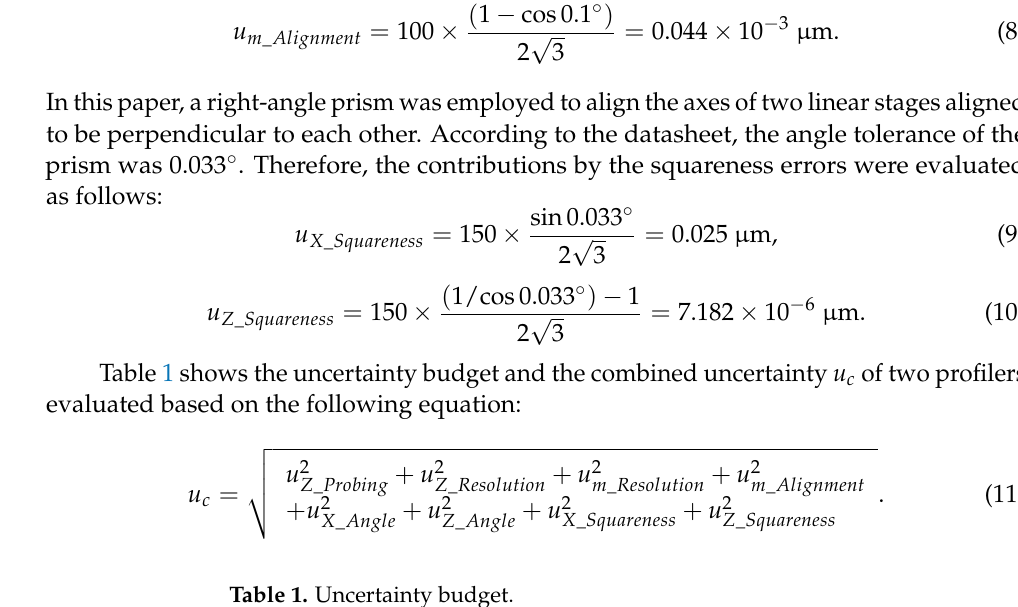
Table 1. Uncertainty